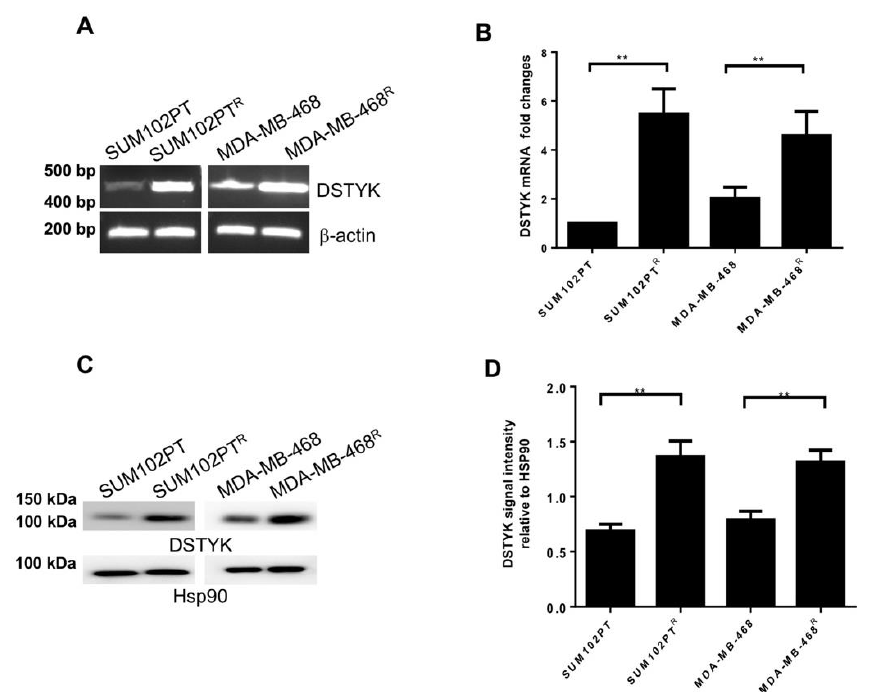
Figure 3. DSTYK expression correlates with chemoresistance. ( A ) The mRNA level of DSTYK between parental and chemoresistant cells by reverse-transcription PCR (RT-PCR) and ( B ) qPCR. ( C , D ) WB and quantification to detect the expressions of DSTYK in SUM102PT and SUM102PT R cells, and MDA-MB-468 and MDA-MB-468 R cells, respectively. Hsp90 was used as the loading con-